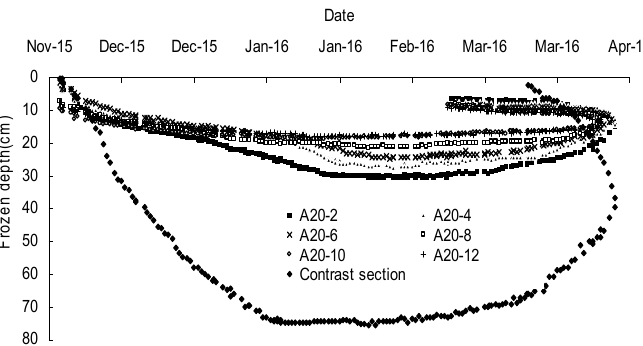
Figure 6. Change process lines of the frozen depths under the different EPS thicknesses.